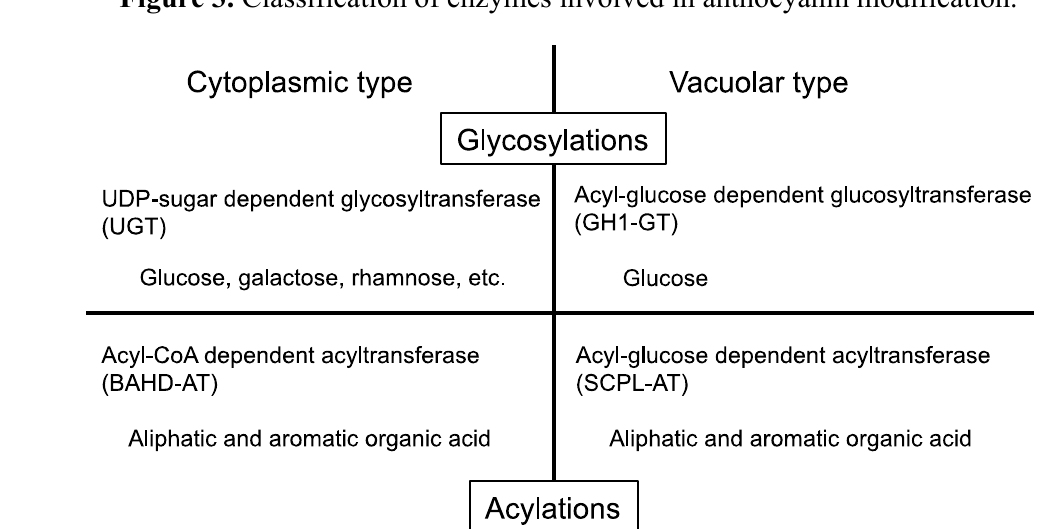
Figure 3. Classification of enzymes involved in anthocyanin